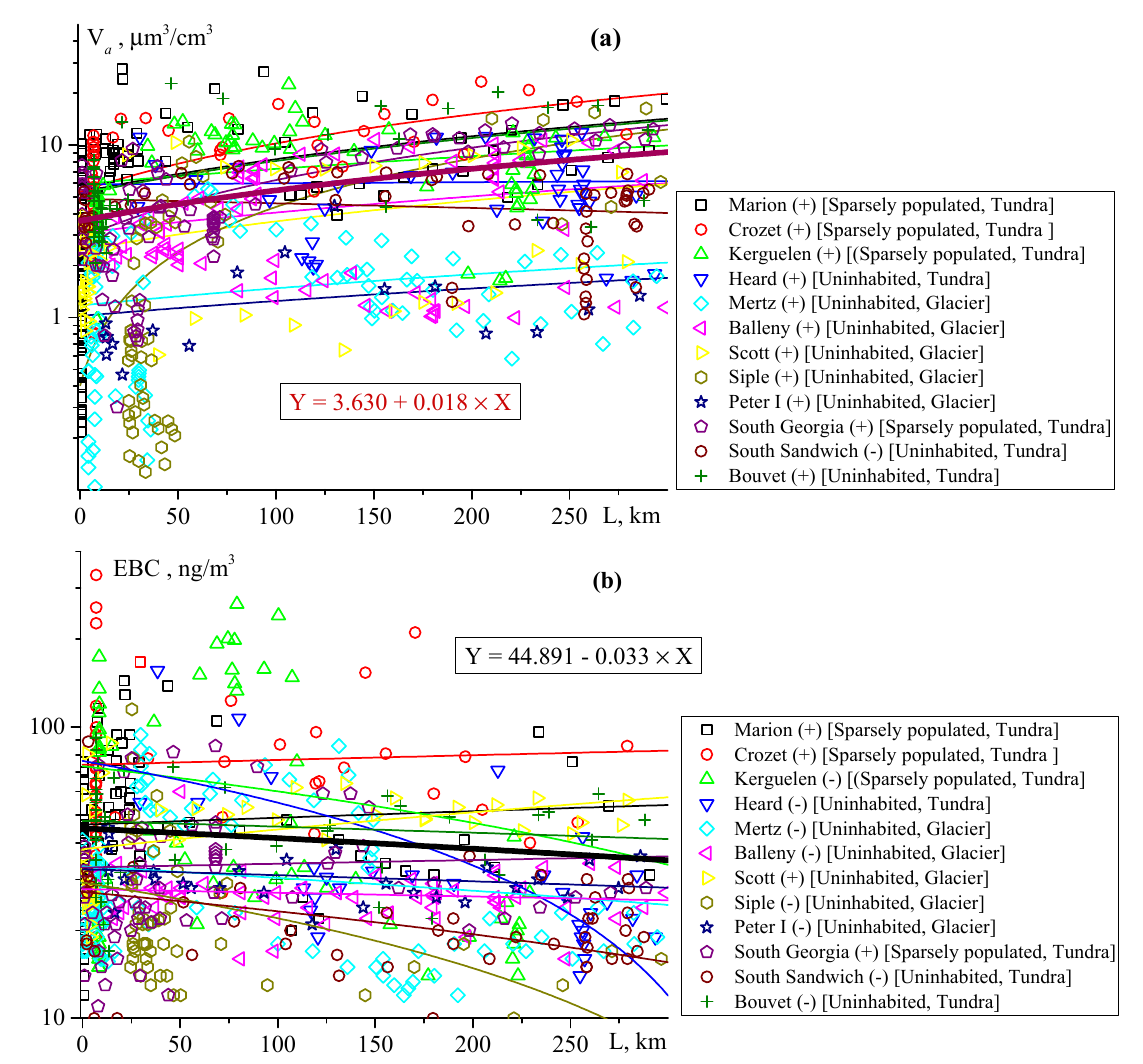
Figure 9. Changes in concentrations of ( a ) black carbon and ( b ) particle volumes with increasing separation distance from Antarctic islands.